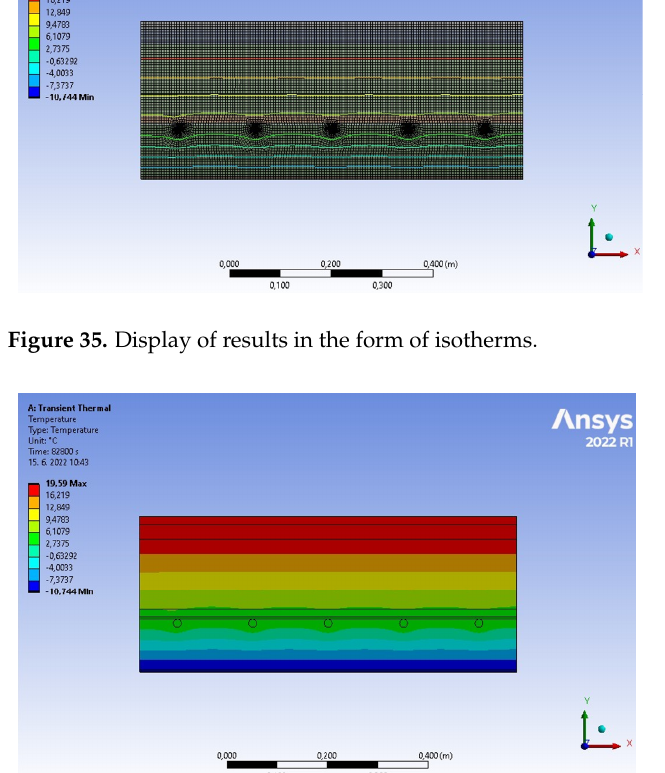
Figure 36. Display of the results with the building envelope structure visible.